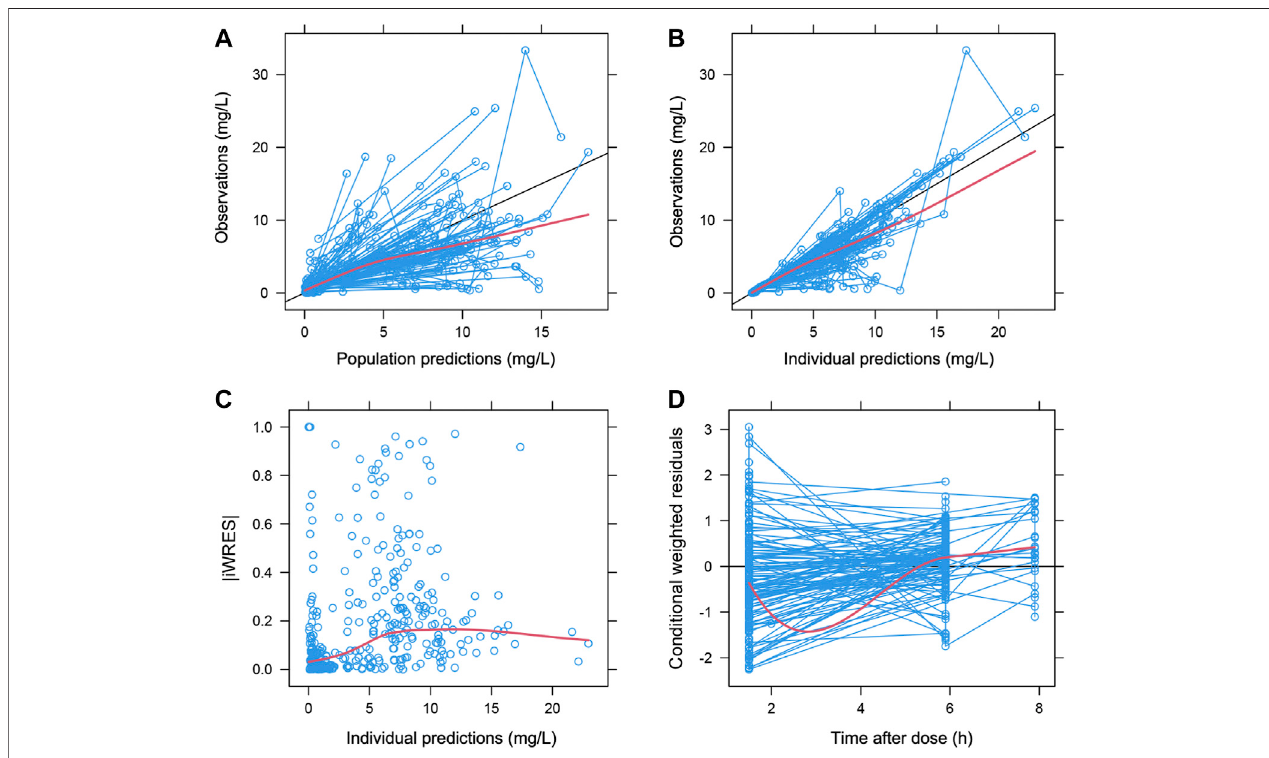
FIGURE3| Goodness-of- fi tplots.Population (A) andindividual (B) predictionvaluesvs.observations. (C) ,absolutevaluesofindividualweightedresiduals(iWRES) error vs. individual predictions and (D) conditional weighted residuals vs. time. Symbols, individual plasma concentrations of acyclovir. Red lines, regression, and Loess lines. Black line, line of identity.